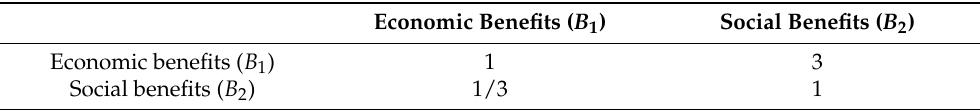
Table 4. Matrix relationship between layer B and layer A.